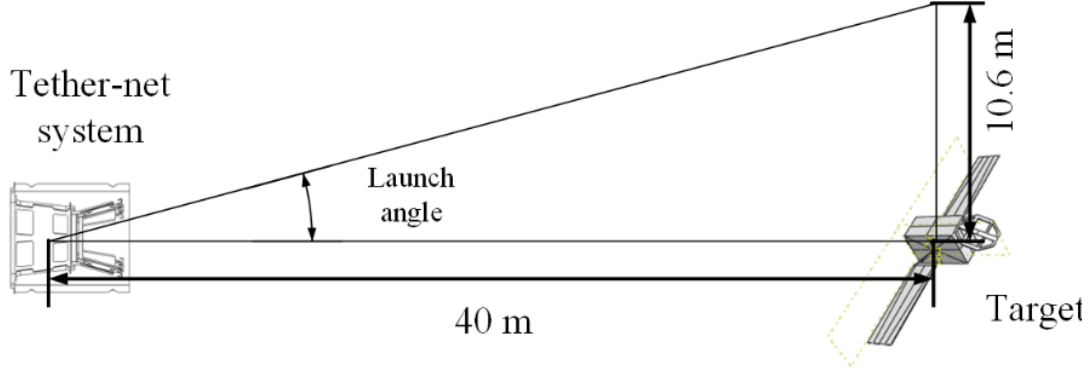
Figure 3. Schematic diagram of launching angle setting.